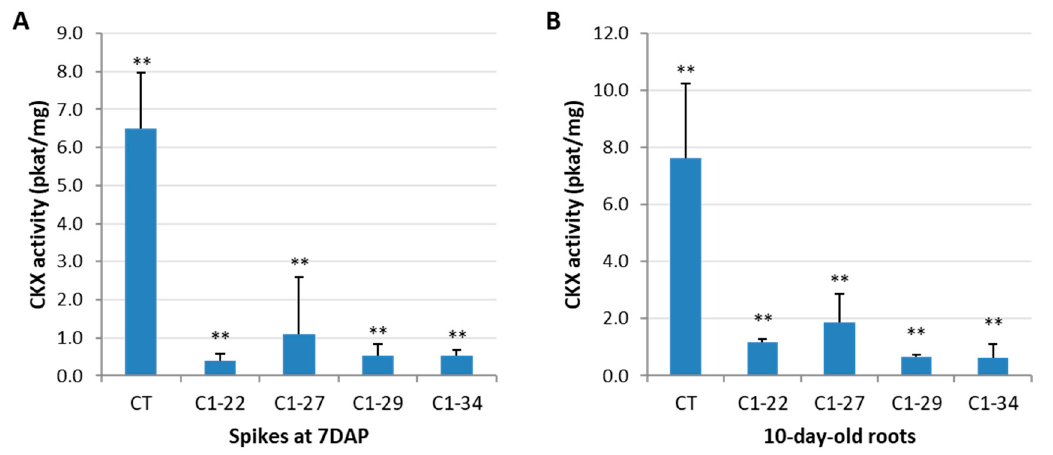
Figure 2. Enzymatic cytokinin oxidase/dehydrogenase enzymes (CKX) activity (pkat/mg) in seven days after pollination (DAP) spikes ( A ) and the 10-day-old roots ( B ) of ckx1 mutant lines. CT, control plants. The activity assay was carried out for three to eight biological replicates, and two technical replicates were measured per sample, which was significantly different from the control at * p < 0.05, ** p < 0.01.